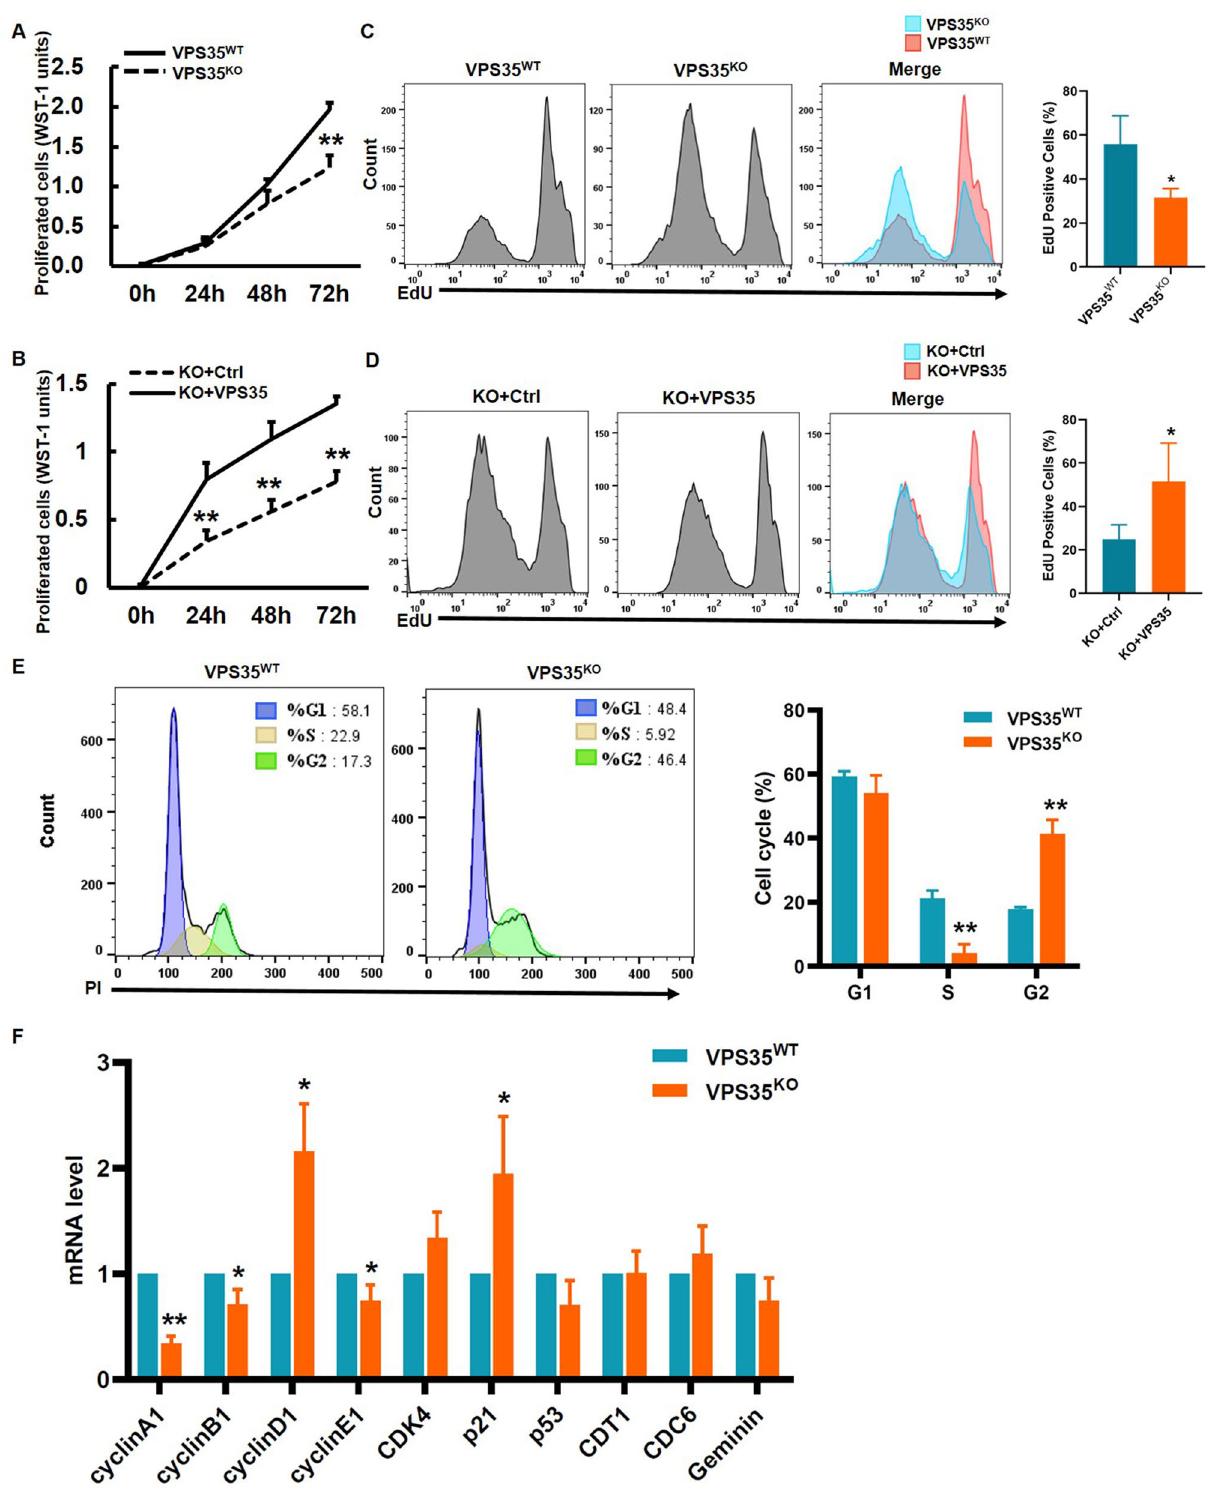
Figure 6. VPS35 enhances the proliferation potential of HeLa cells. ( A – D ) HeLa cell proliferation was measured by the WST-1 assay ( A and B ) and EdU incorporation assay ( C and D ). The ratio of EdU-positive cells to total cells was quantified by FlowJo software from three independent experiments, and expressed as the mean ± S.D. (right panels of C and D ).*, p < 0.05; **, p < 0.01. ( E ) DNA content was measured by FACS analysis using propidium iodide (PI) staining. The cell cycle distribution was analyzed using FlowJo software. Histograms show the percentage of the cell cycle in HeLa cells. **, p < 0.01 vs. VPS35 WT . ( F ) The mRNA levels of cell cycle-related factors, including cyclin A1, cyclin B1, cyclin D1, cyclin E1, CDK4, p21, p53, CDC6, CDT1 and Geminin, were examined by qRT–PCR. Each gene expression value is expressed as the mean ± S.D. derived from three independent experiments. *, p < 0.05 vs. VPS35 WT ; **, p < 0.01 vs. VPS35 WT